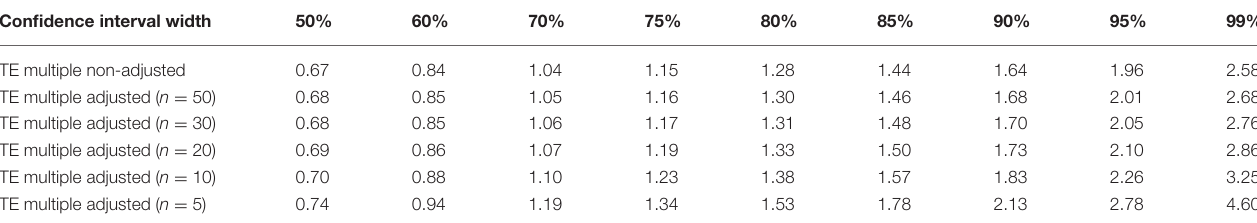
TABLE 2 | Typical error multiples required to calculate confidence intervals of different widths (non-adjusted and adjusted for sample size). Confidence interval